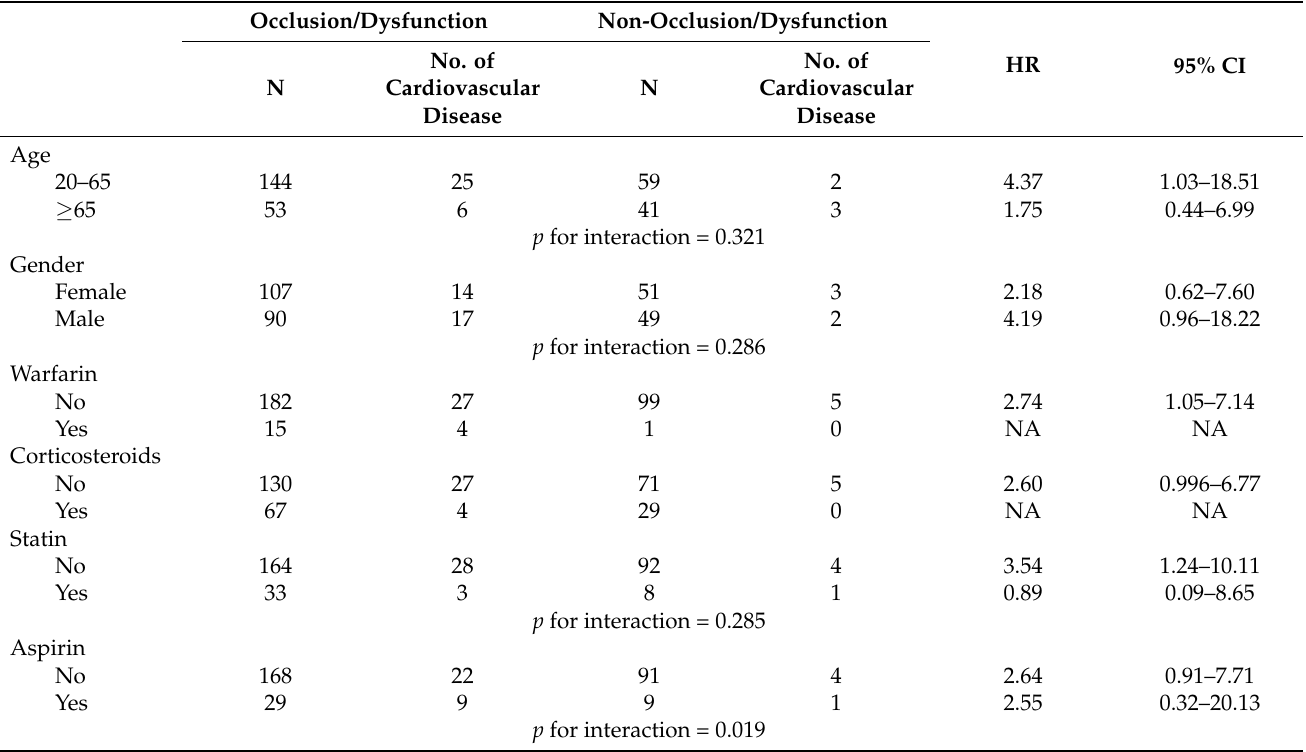
Table 3. Subgroup analysis of Cox proportional hazard